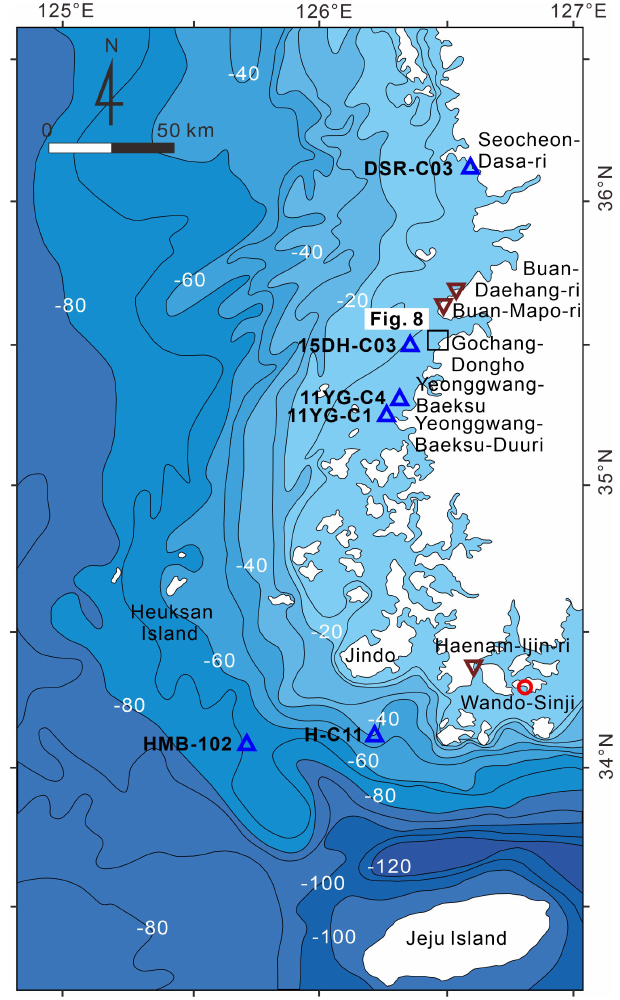
Figure 7. Location of nearshore drill cores and onshore sites in the western Korean Peninsula. A red circle represents the location of the sea-level indicator, while blue triangles and brown inverted triangles represent marine limiting and terrestrial limiting site loca- tions, respectively. Age data can be found in Table 3. Bathymetric contour interval is in meters.